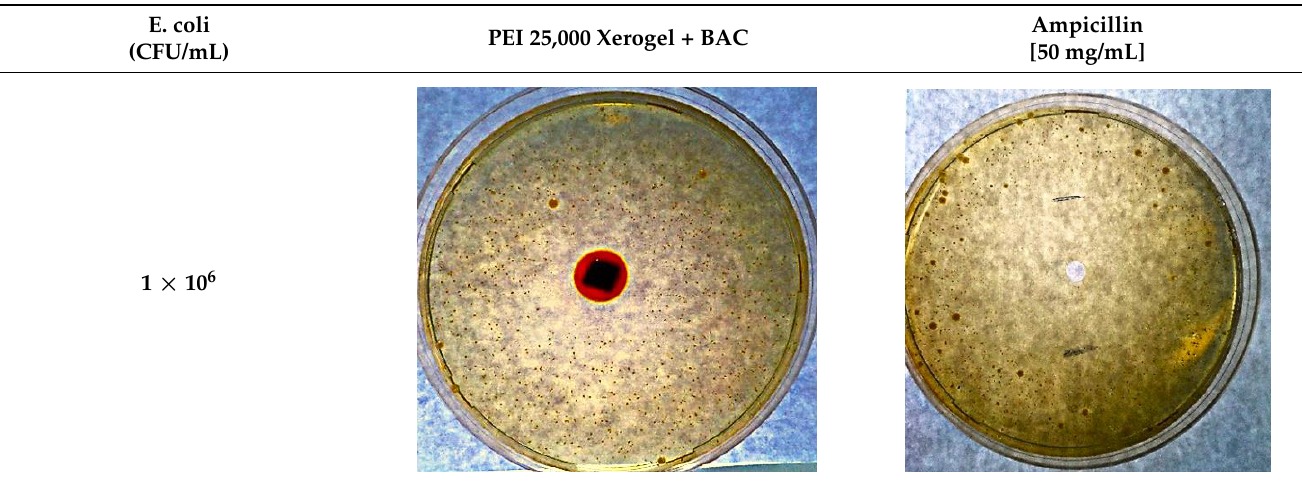
Table 7. Luria – Bertani (LB)-medium agar plates, bearing at the center either leather samples (left) or 20 μ L ampicillin (50 μ g/mL) (right), incubated with different densities of Escherichia coli ATCC 25922 E cultures.